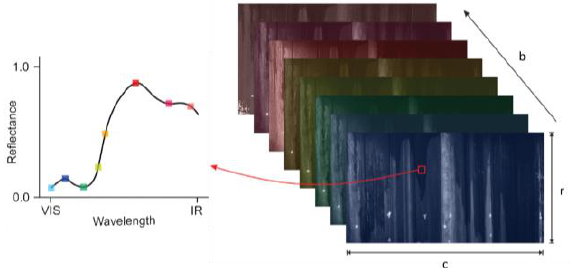
Figure 4. r×c×b multispectral image and a spectral signature The analysis of these data consists of a classification to identify and